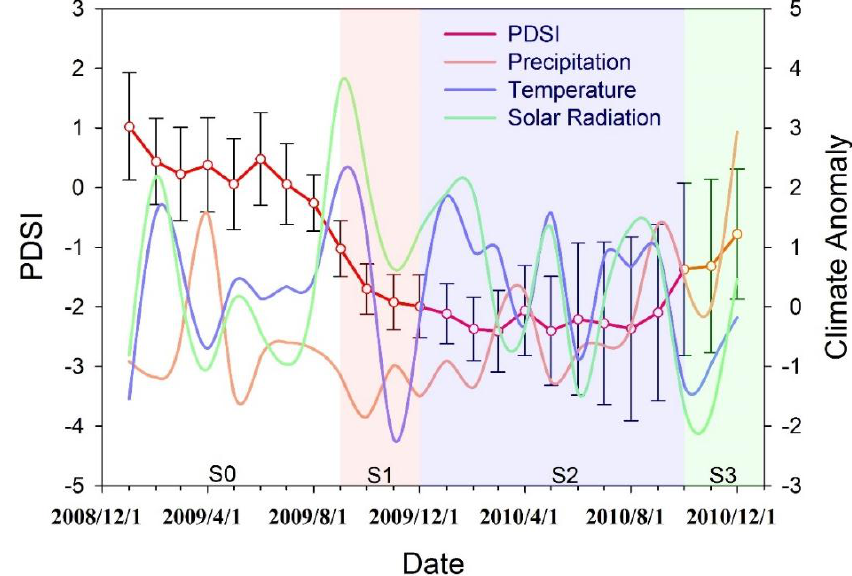
Figure 2. Monthly time series of PDSI, precipitation, temperature, and solar radiation based on the data averaged over all pixels in the study area. The vertical coordinate on the left side displays the PDSI value, and the vertical coordinate on the right side shows the Z-score of precipitation, temperature, and radiation. The standard error of PDSI is calculated by all pixels in the study area in the corresponding month. Based on the PDSI value in the study area, the drought in the study area can be separated into three stages: initial stage (S1), middle stage (S2), and final stage (S3). S0 represents normal condition before the